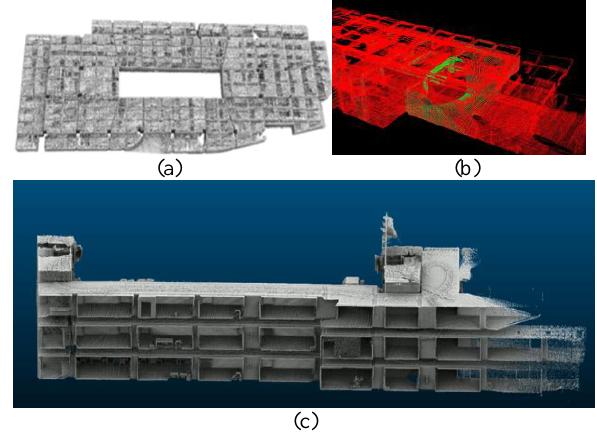
Figure 4. (a) 3D map of the underground scene. (Wang et al., 2018) (b) A close look of 3D map of the underground scene. (c) 3D map of multi-floor building scene.